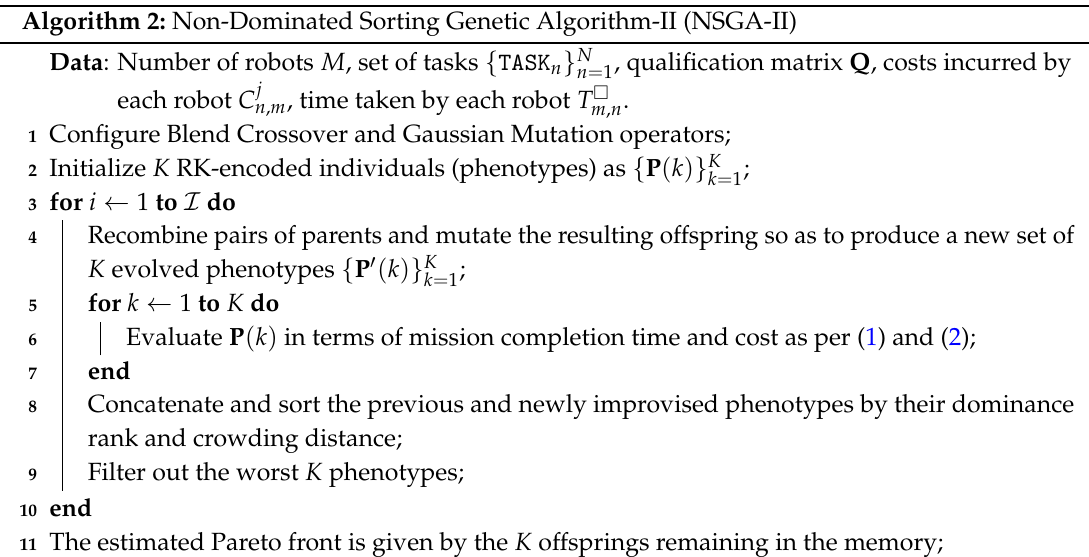
Algorithm 3: Pareto-Archived Evolution Strategy